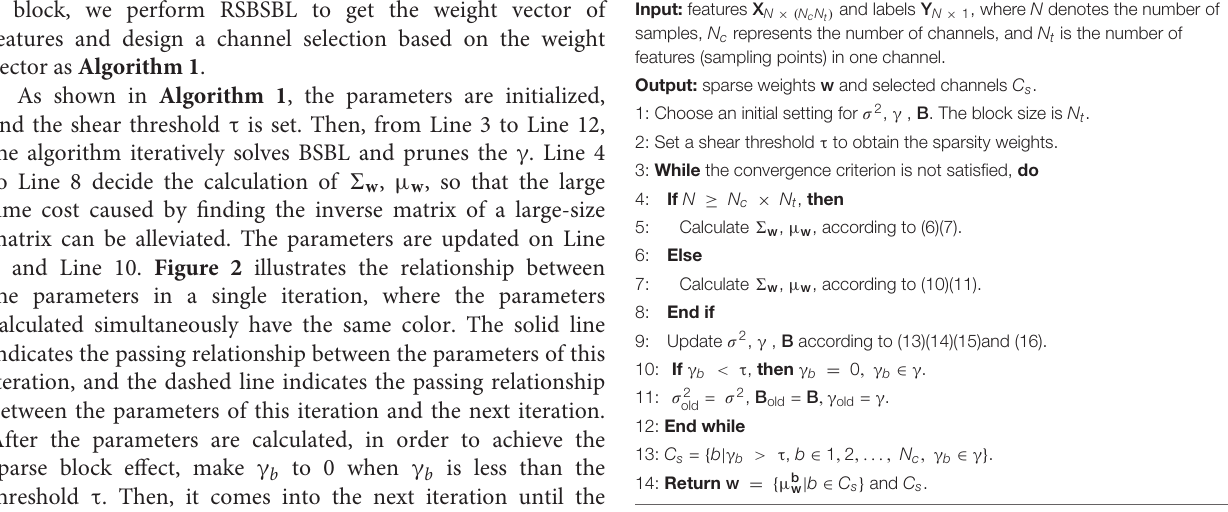
Algorithm 1 : Regional Smoothing Sparse Bayesian Learning